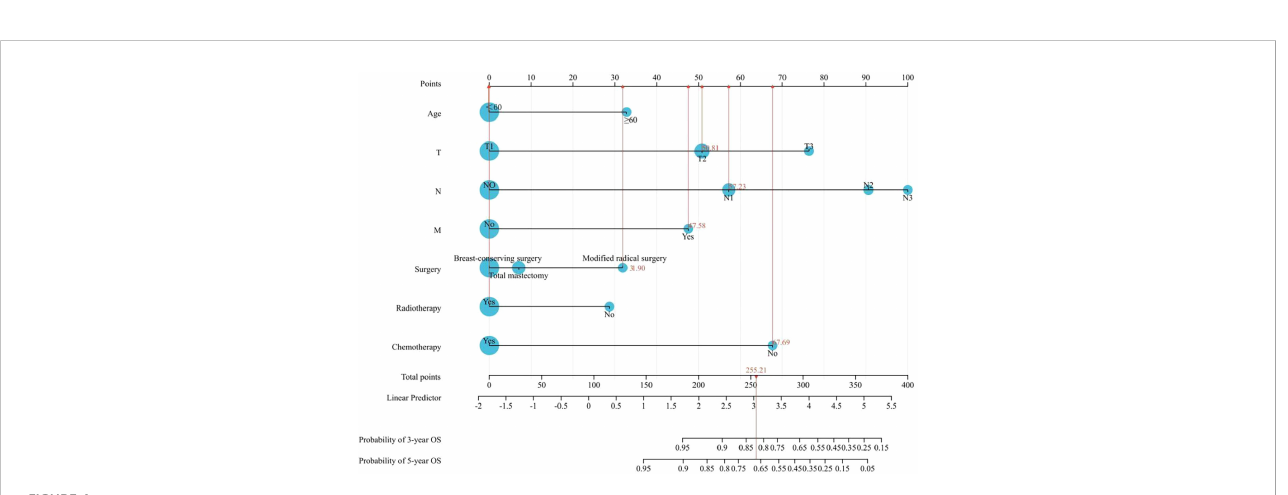
FIGURE 4 Nomogram prediction model for prognosis of TPBC